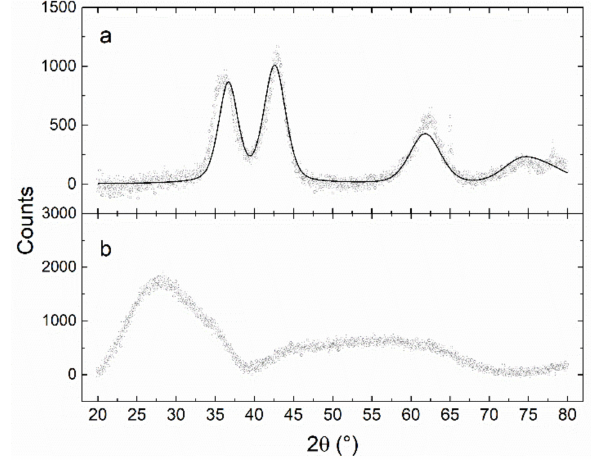
Figure 3. XRD patterns of as-prepared TiO x NPs. ( a ) Ti-O_l; ( b ) Ti-O_h. The grey circles represent experimental data. The result of Rietveld refinement is shown for Ti-O_l as a black solid